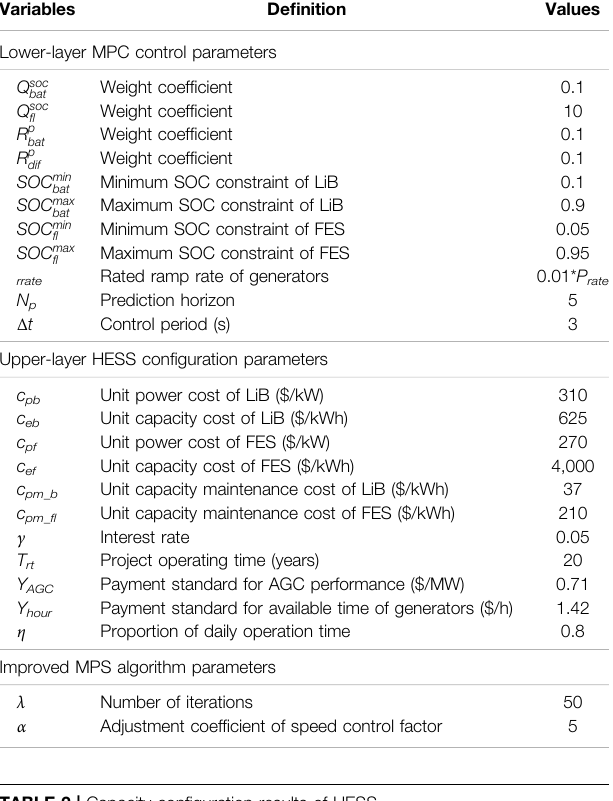
TABLE 2 | Capacity con fi guration results of HESS.